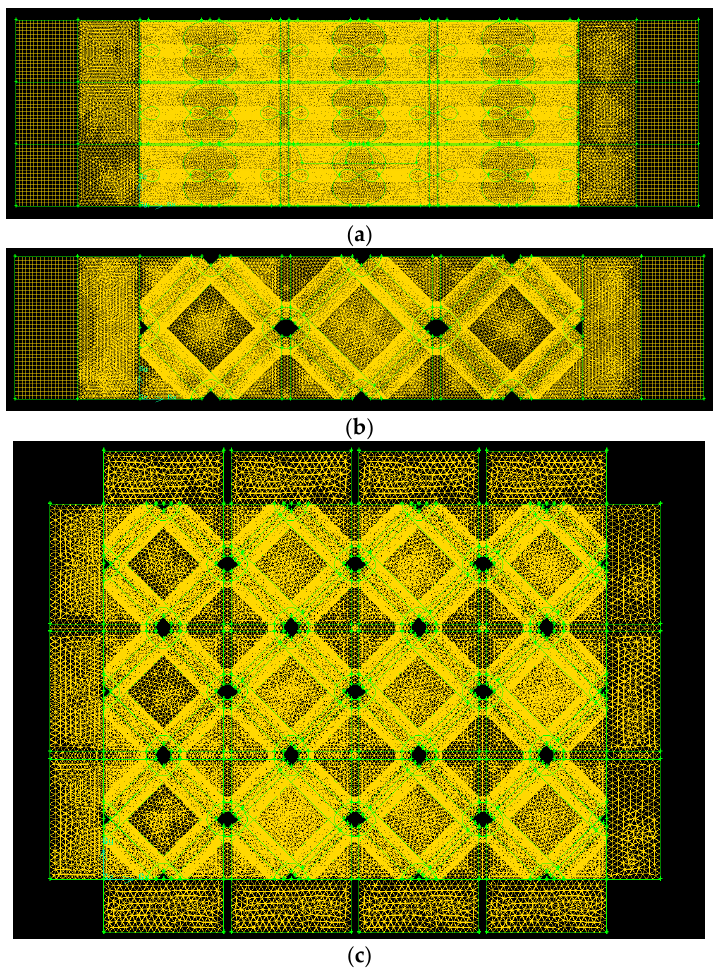
Figure 5. Computational grid for CFD simulation of HASMCs with spacers ( a ) parallel-flow (side view), ( b ) parallel-flow (top view), ( c ) cross-flow (top view)).